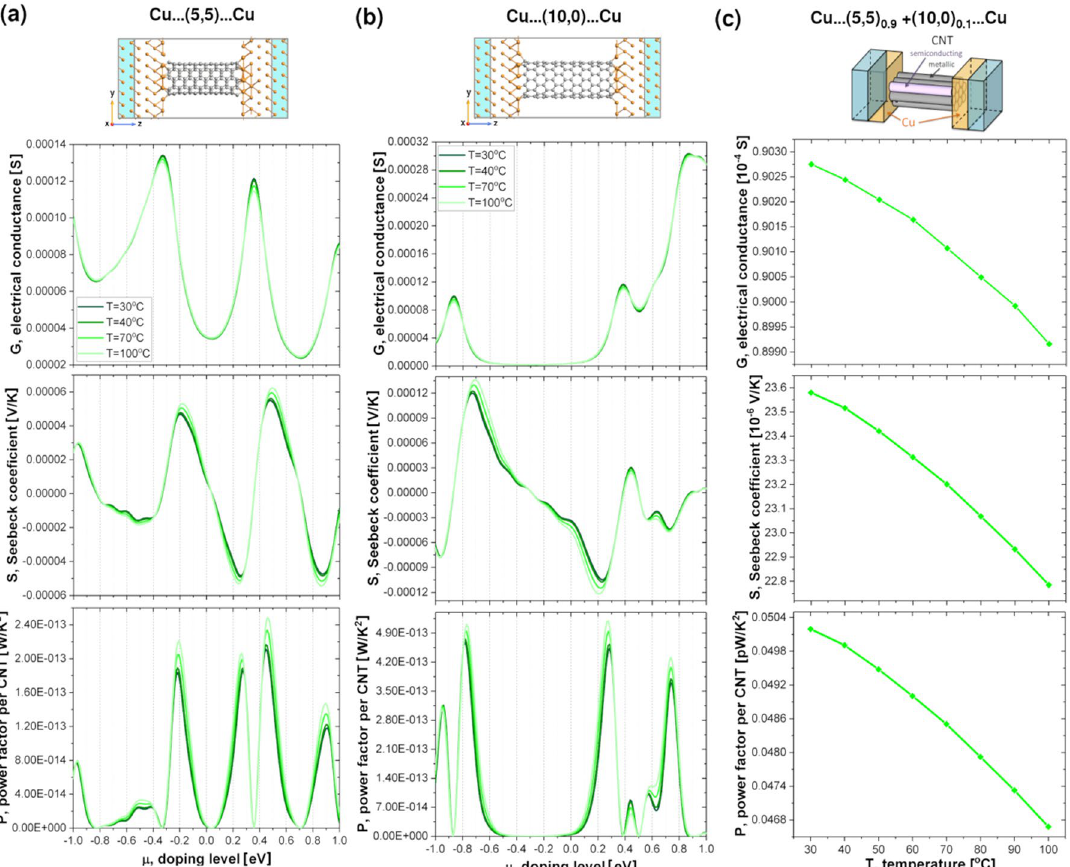
Figure 9. Computed thermoelectric properties of pristine ( a ) metallic (5,5) and ( b ) semiconducting (10,0) CNTs and ( c ) mixed parallel CNT circuits sandwiched between Cu electrodes. ( a , b ) Conductance (G), Seebeck coefficient (S) and Power Factor per CNT (P) are plotted as a function of doping level (μ) for four different temperatures: 30, 40, 70, and 100 °C. The atomistic side view of the models used for the transport calculations are presented at the top of the figure. C atoms are depicted in grey while Cu atoms are shown in orange. The semi-infinite electrodes consisting of perfect copper are depicted in blue. ( c ) G, S, P at different temperatures for a pristine CNT film containing 90% of metallic (5,5) and 10% semiconducting (10,0) CNTs with μ = − 0.99 eV computed using CNT bundles model adopted from Hayashi et al. 65 . The 3D visualisation of the model is shown